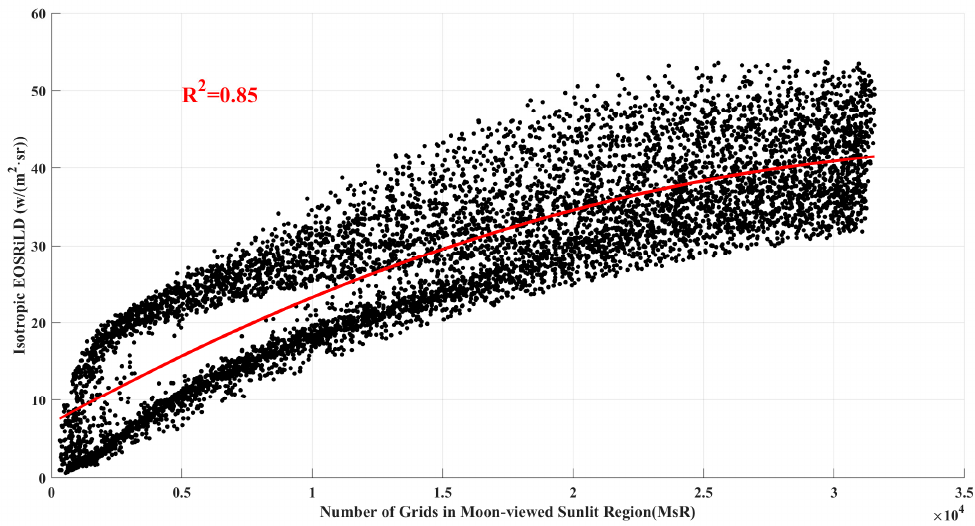
Figure 12. Changes in daily EOSRiLD and areas of MsR in 2016 and 2019.